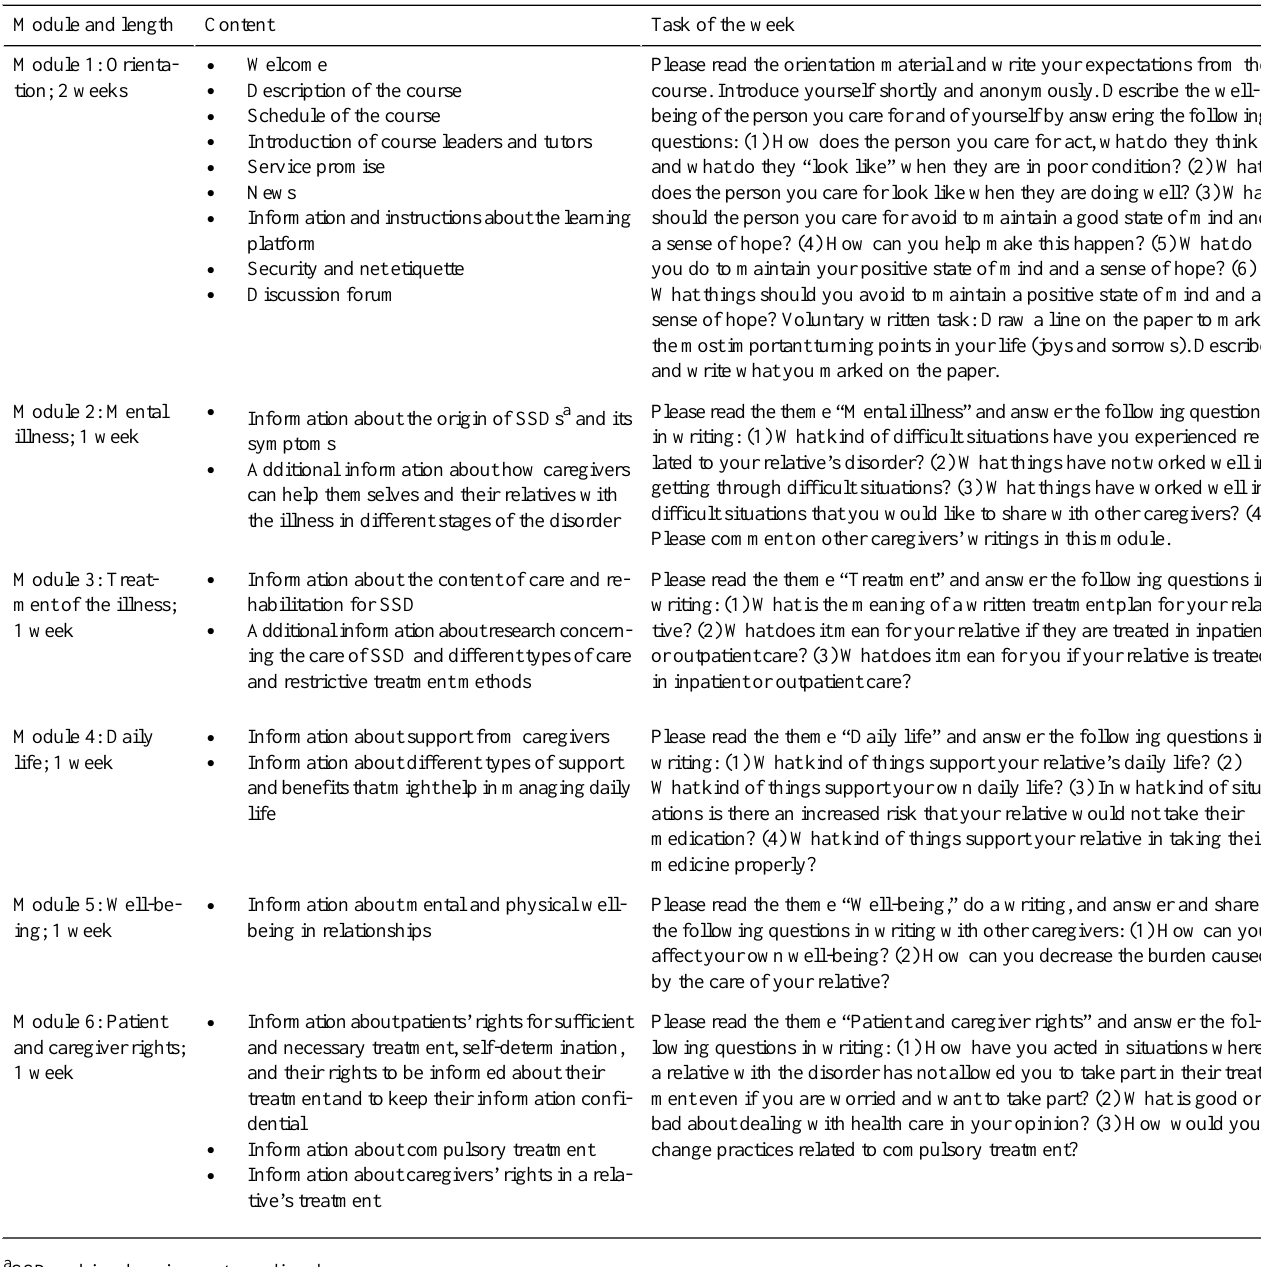
Table 1. Description of the structure and content of the web-based psychoeducation course.